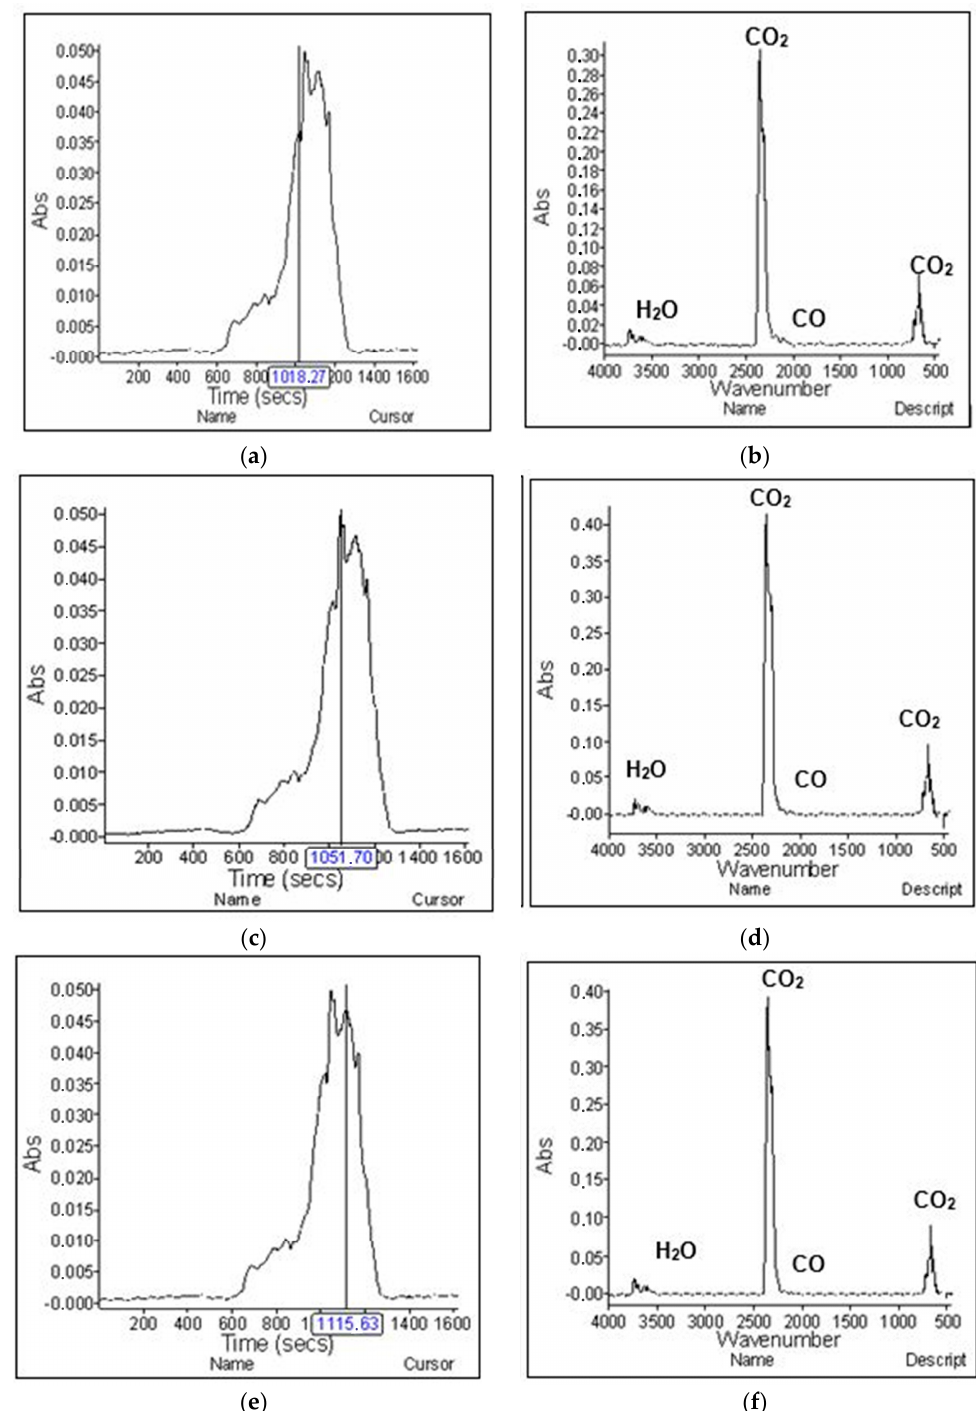
Figure 14. TG-IR analysis of sample. ( a ) The first intense absorption spectrum; ( b ) measured gases on IR at a temperature of 509.13 °C: ( c ) second absorption spectrum; ( d ) measured gases on IR at a temperature of 525.85 °C; ( e ) third absorption spectrum; ( f ) measured gases on IR at a temperature of 557.82 °C.